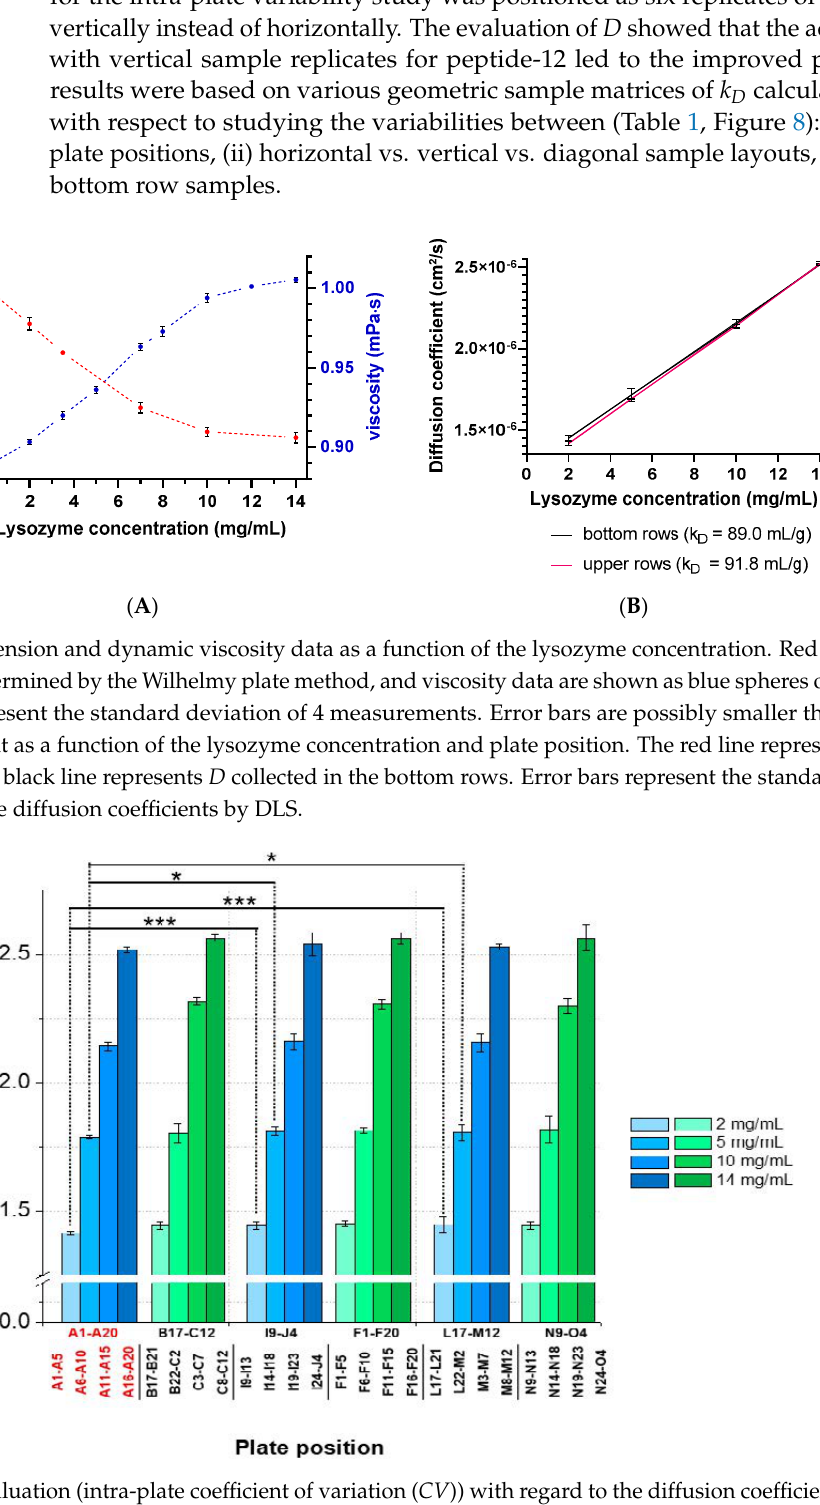
Figure 7. Statistical evaluation (intra-plate coefficient of variation ( CV )) with regard to the diffusion coefficients as a function of plate position collected for two lysozyme batches (LysSig2243: blue and LysSig5161: green); 4 concentrations (2, 5, 10, and 14-mg/mL lysozyme); and 5 replicates. Edge rows (A1–A20) are marked in red. The plate design is shown in Figure 1. Significant differences are indicated by asterisks: * p < 0.05 and *** p <